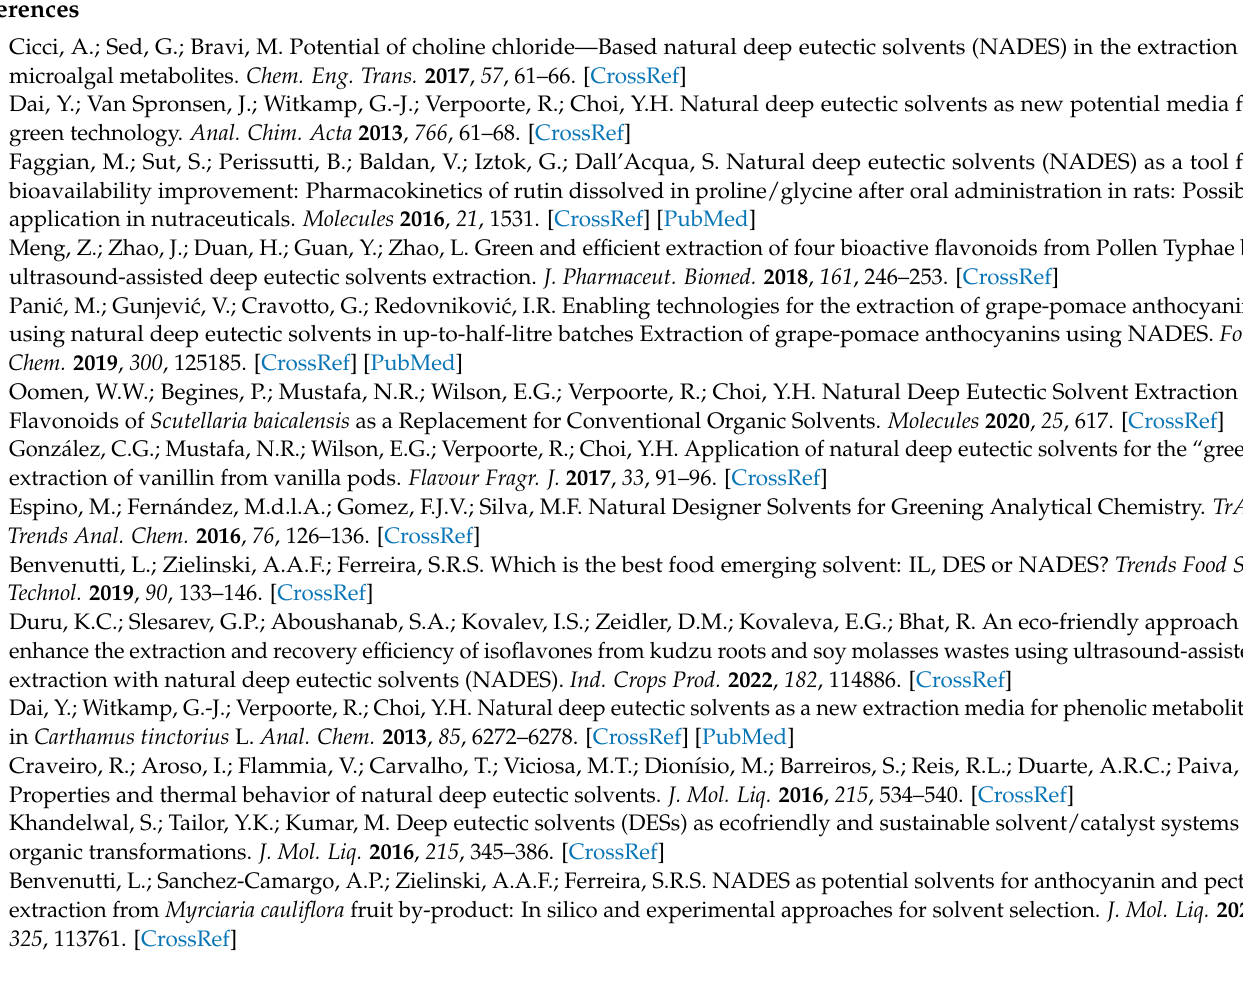
nents; Figure S2. Spectra (FTIR) of pure components; Figure S3. Spectra (FTIR) of pure components; Figure S4. Spectra (FTIR) of pure components; Figure S5. Raman spectra of pure components; Figure S6. Raman spectra of pure components; Figure S7. Raman spectra of pure components; Figure S8. Raman spectra of pure components; Figure S9. Flow curves for NADES fitted to Newton’s model at 40 ◦ C. Figure S10. Viscosity profile graph for NADES at 40 ◦ C; Table S1. Tests performed for extractions with